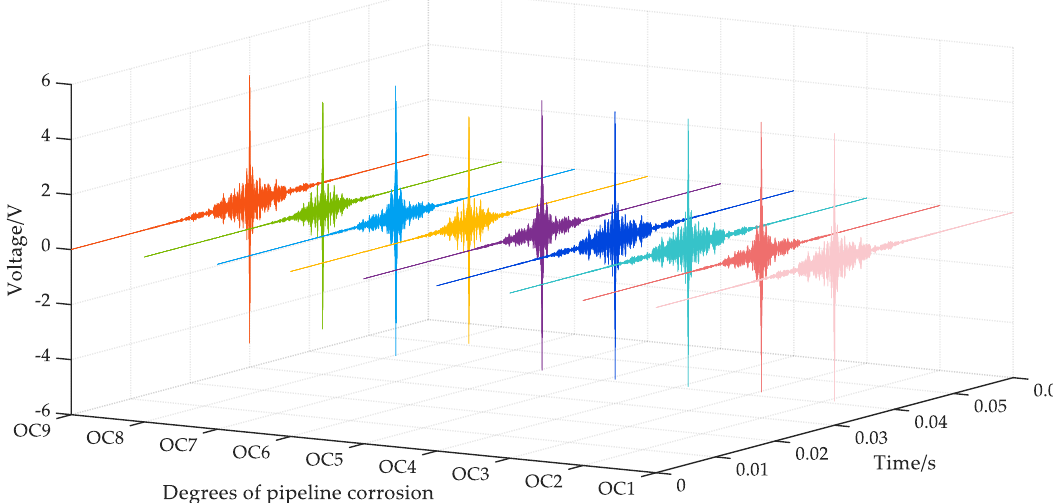
Figure 6. Relationship between the wall thickness and the corrosion time.